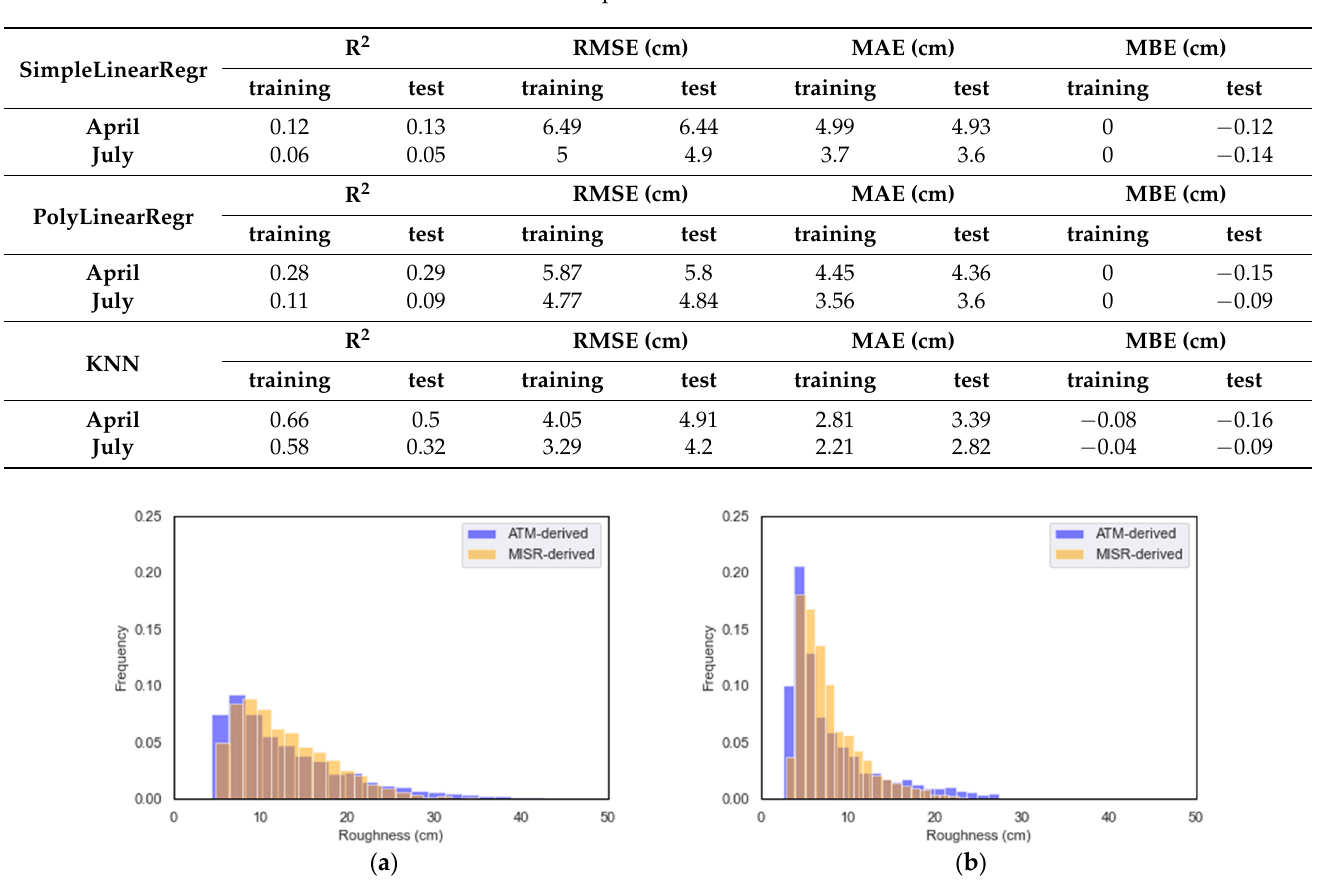
Table 1. Statistics of model performance.